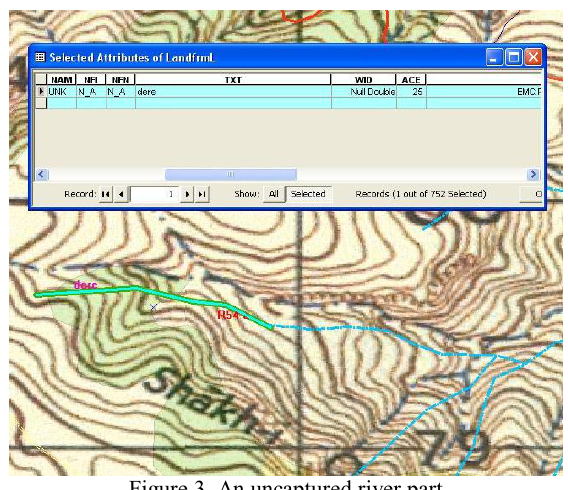
Figure 3. An uncaptured river part